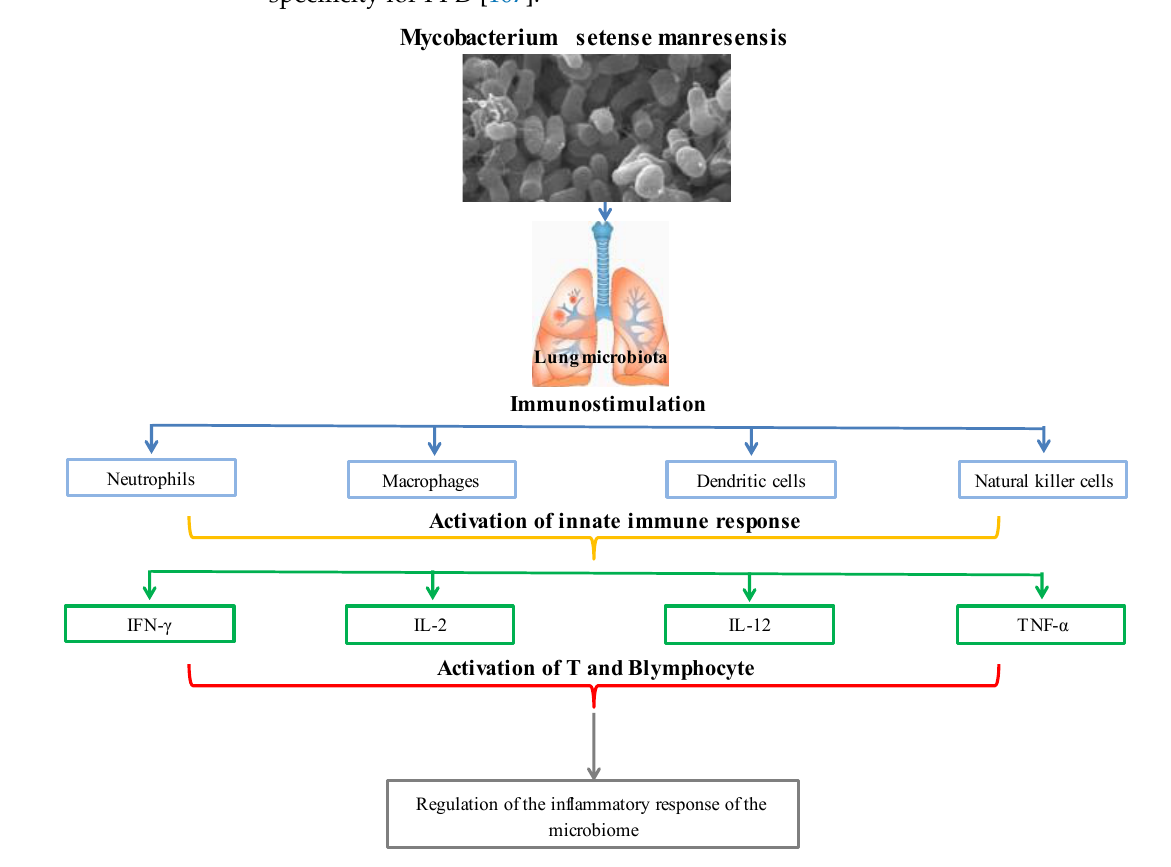
Figure 4. Immune system regulation of Mycobacterium setense manresensis .